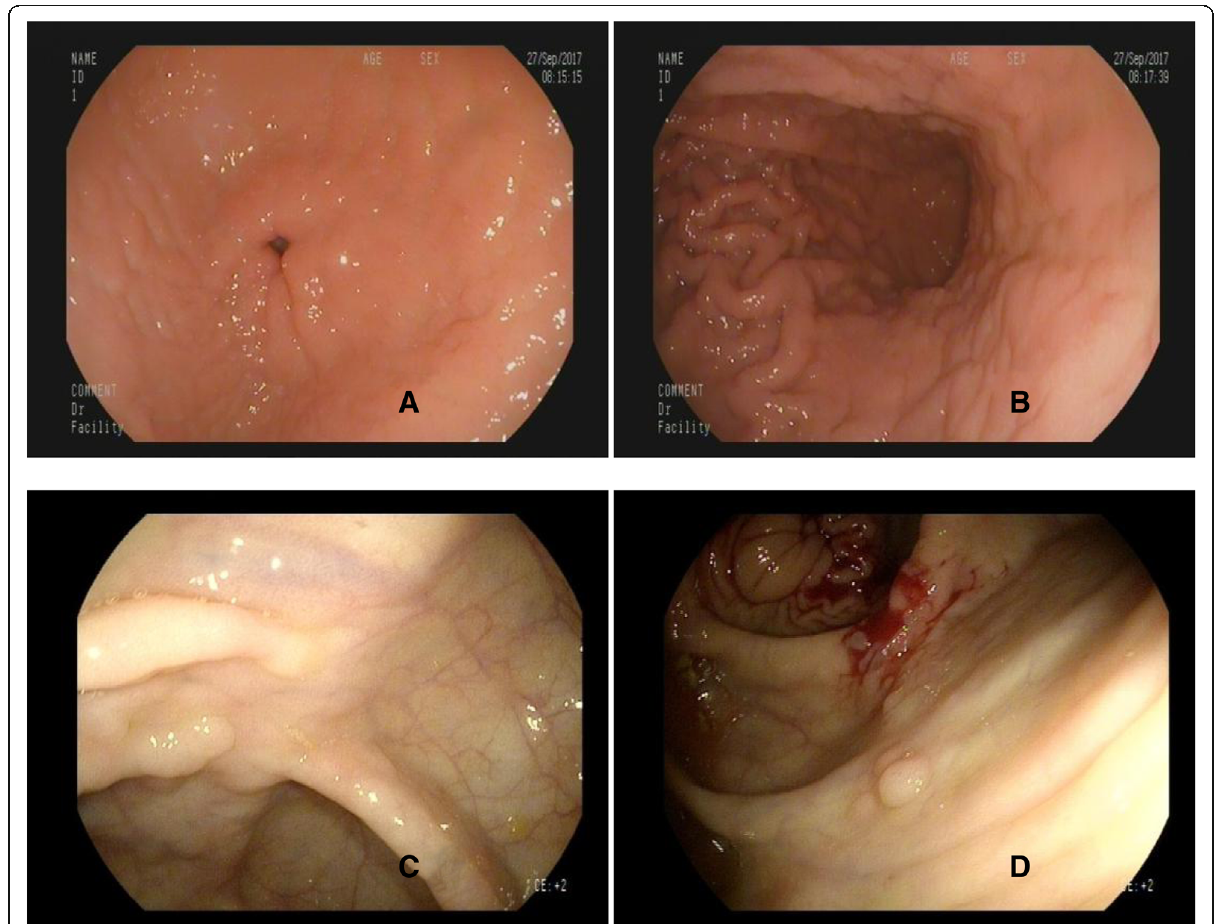
Fig. 1 Endoscopic findings in indolent T-cell LPD of the GIT in 2017. Irregular appearance of Gastric antrum ( a ) and Gastric body ( b ) mucosa. Multiple wide pedicle polyps were found in the ileocecal ( c ) and ascending colon ( d